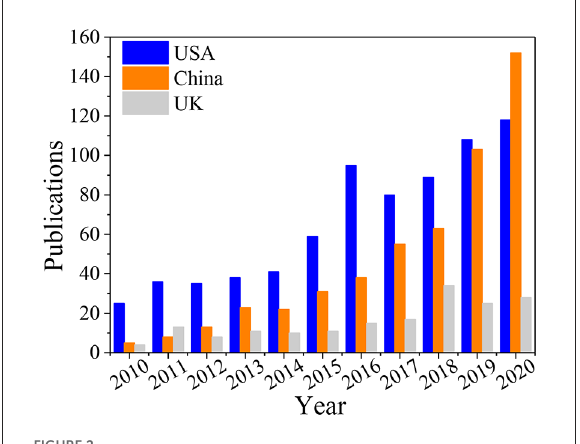
FIGURE2 Number of ARB-related publications per year from 2010 to 2020 in the USA, China and the UK.